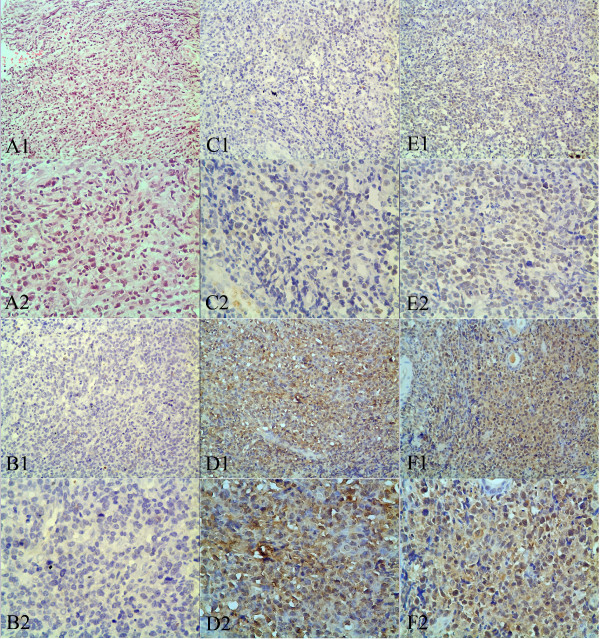
Immunohistochemical staining of LMP1 and LMP2A in clinical tissue samples of ENKTL. (A1 and A2) Hematoxylin-eosin staining of ENKTL tissue samples. (B1 and B2) Negative immunohistochemical staining of adjacent nontumorous tissue. (C1 and C2) Weak immunostaining of LMP1 in ENKTL tissue samples. (D1 and D2) Strong immunostaining of LMP1 in ENKTL tissue samples. (E1 and E2) Weak immunostaining of LMP2A in ENKTL tissue samples. (F1 and F2) Strong immunostaining of LMP2A in ENKTL tissue samples. Original magnification × 200 in A1, B1, C1, D1, E1 and F1; ×400 in A2, B2, C2, D2, E2 and F2.